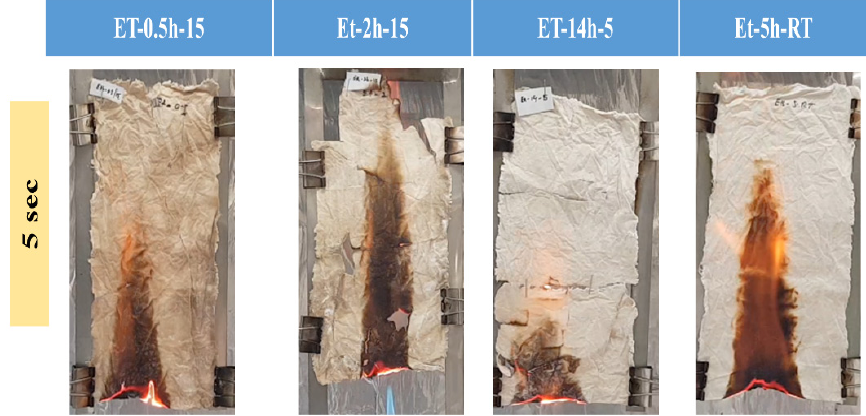
Figure 7. Images of the coated samples obtained after 5 s of flame initiation.